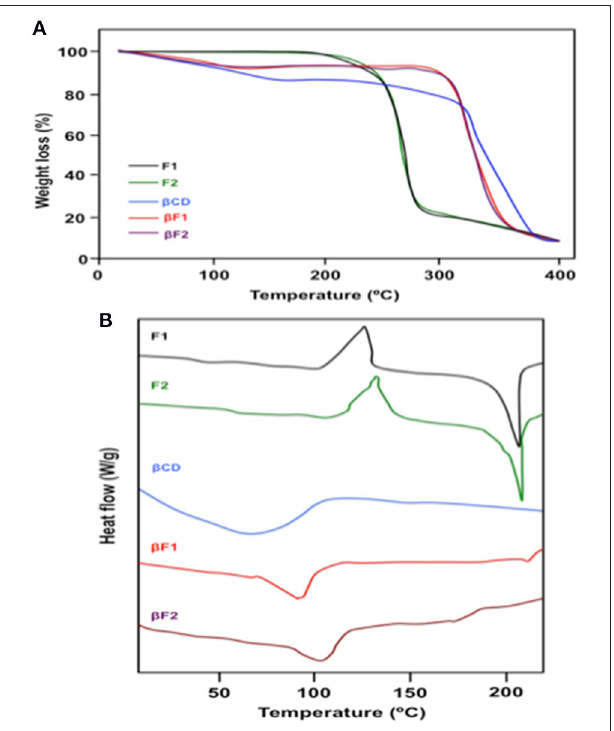
FIGURE 5 | (A) Thermogravimetry analysis (TGA), and (B) DSC thermograms of F1 , F2 , β CD , β F1 , and β F2 .